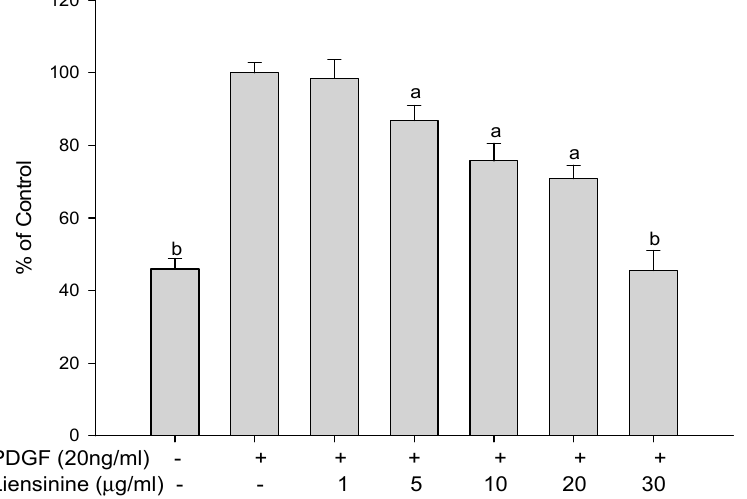
Figure 3. The effect of liensinine on platelet-derived growth factor-BB (PDGF-BB) induced proliferation of human vascular smooth muscle cells (VSMC). VSMC were pretreated with different concentration of liensinine for 1 h followed by stimulation with 20 ng/mL of PDGF-BB for 24 h. The effect on proliferation of VSMC was evaluated by MTT assay. a p < 0.05 and b p < 0.01 vs. Control (only PDGF). n = 3